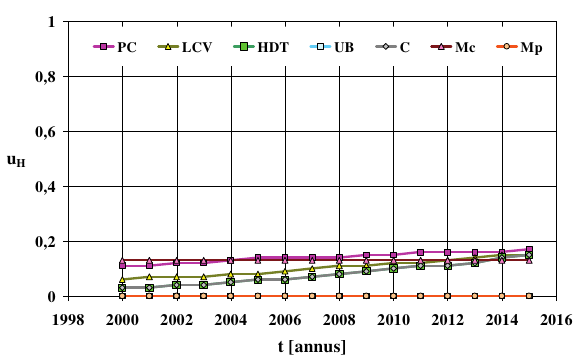
Fig. 8. Average vehicle velocity per cumulated vehicle category, under model traffic conditions: on highways and expressways